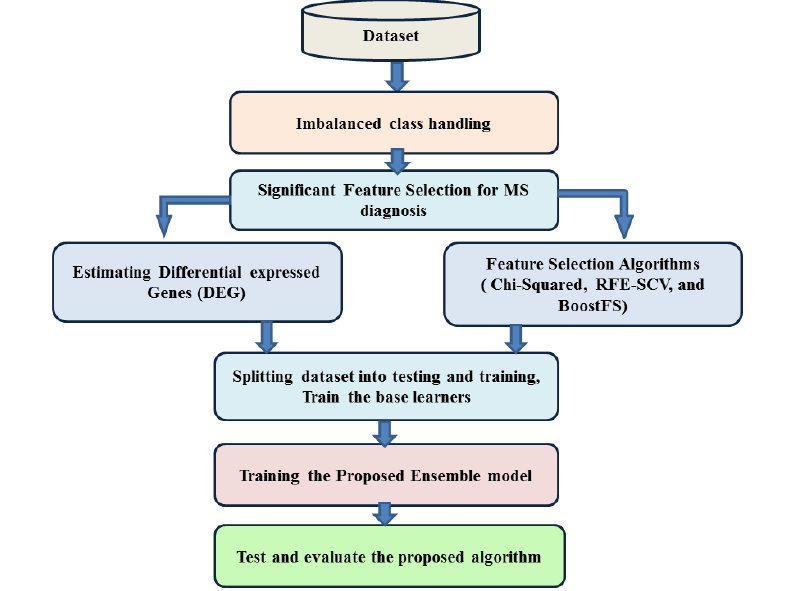
Figure 1. Proposed model